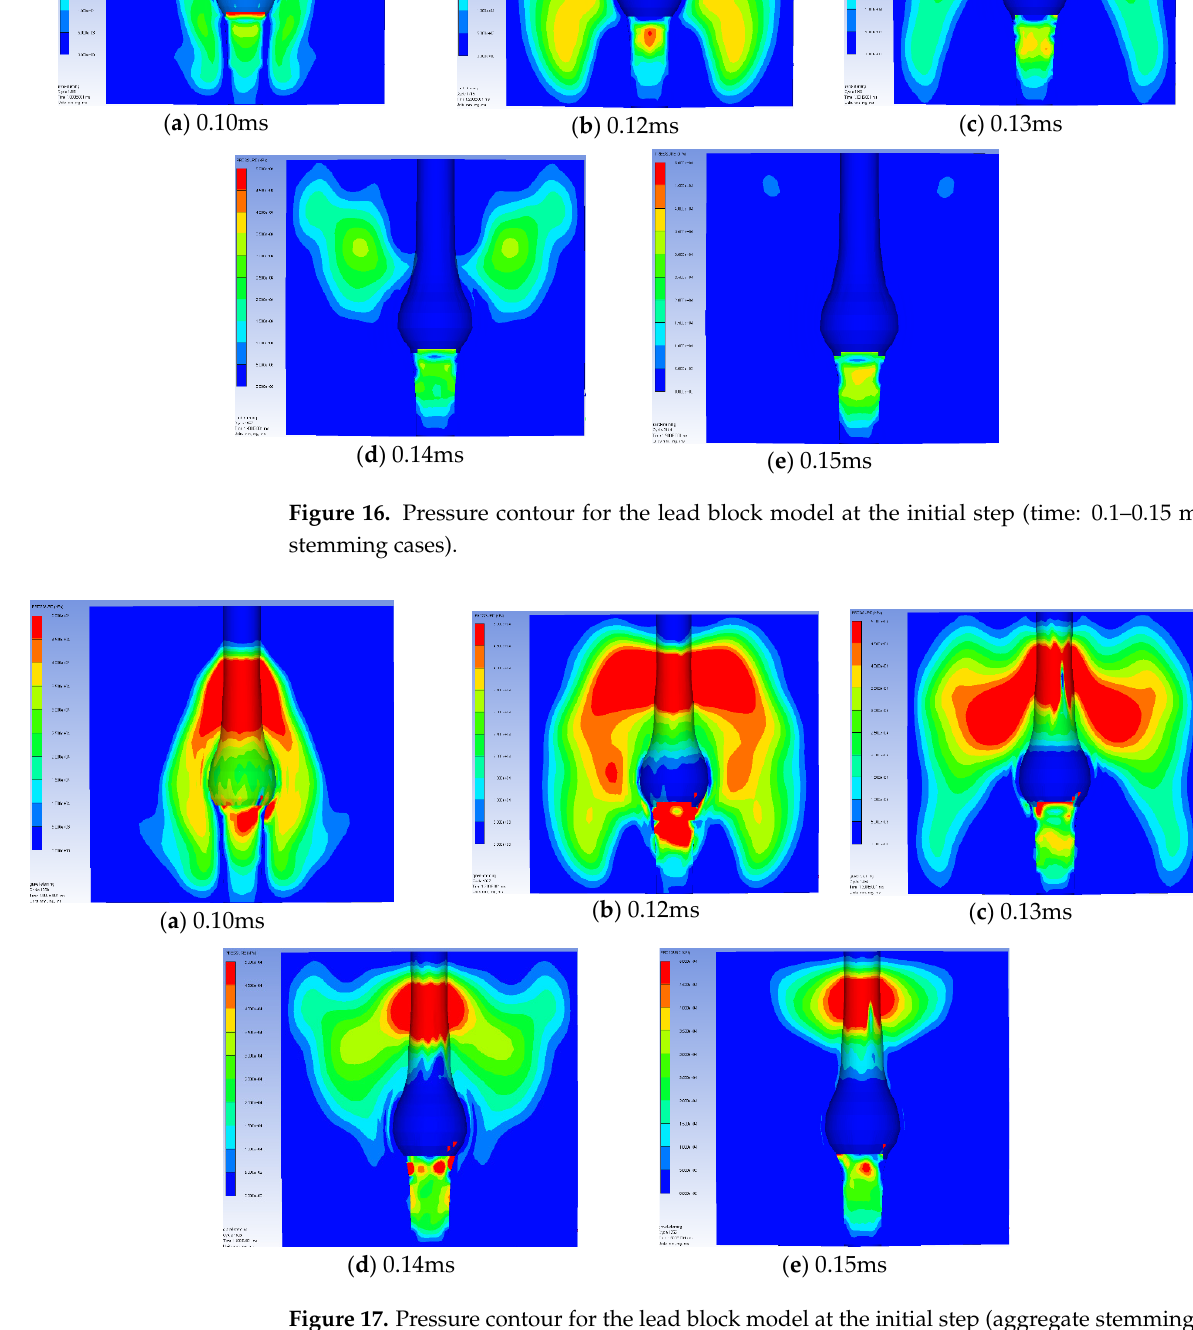
Figure 17. Pressure contour for the lead block model at the initial step (aggregate stemming cases).